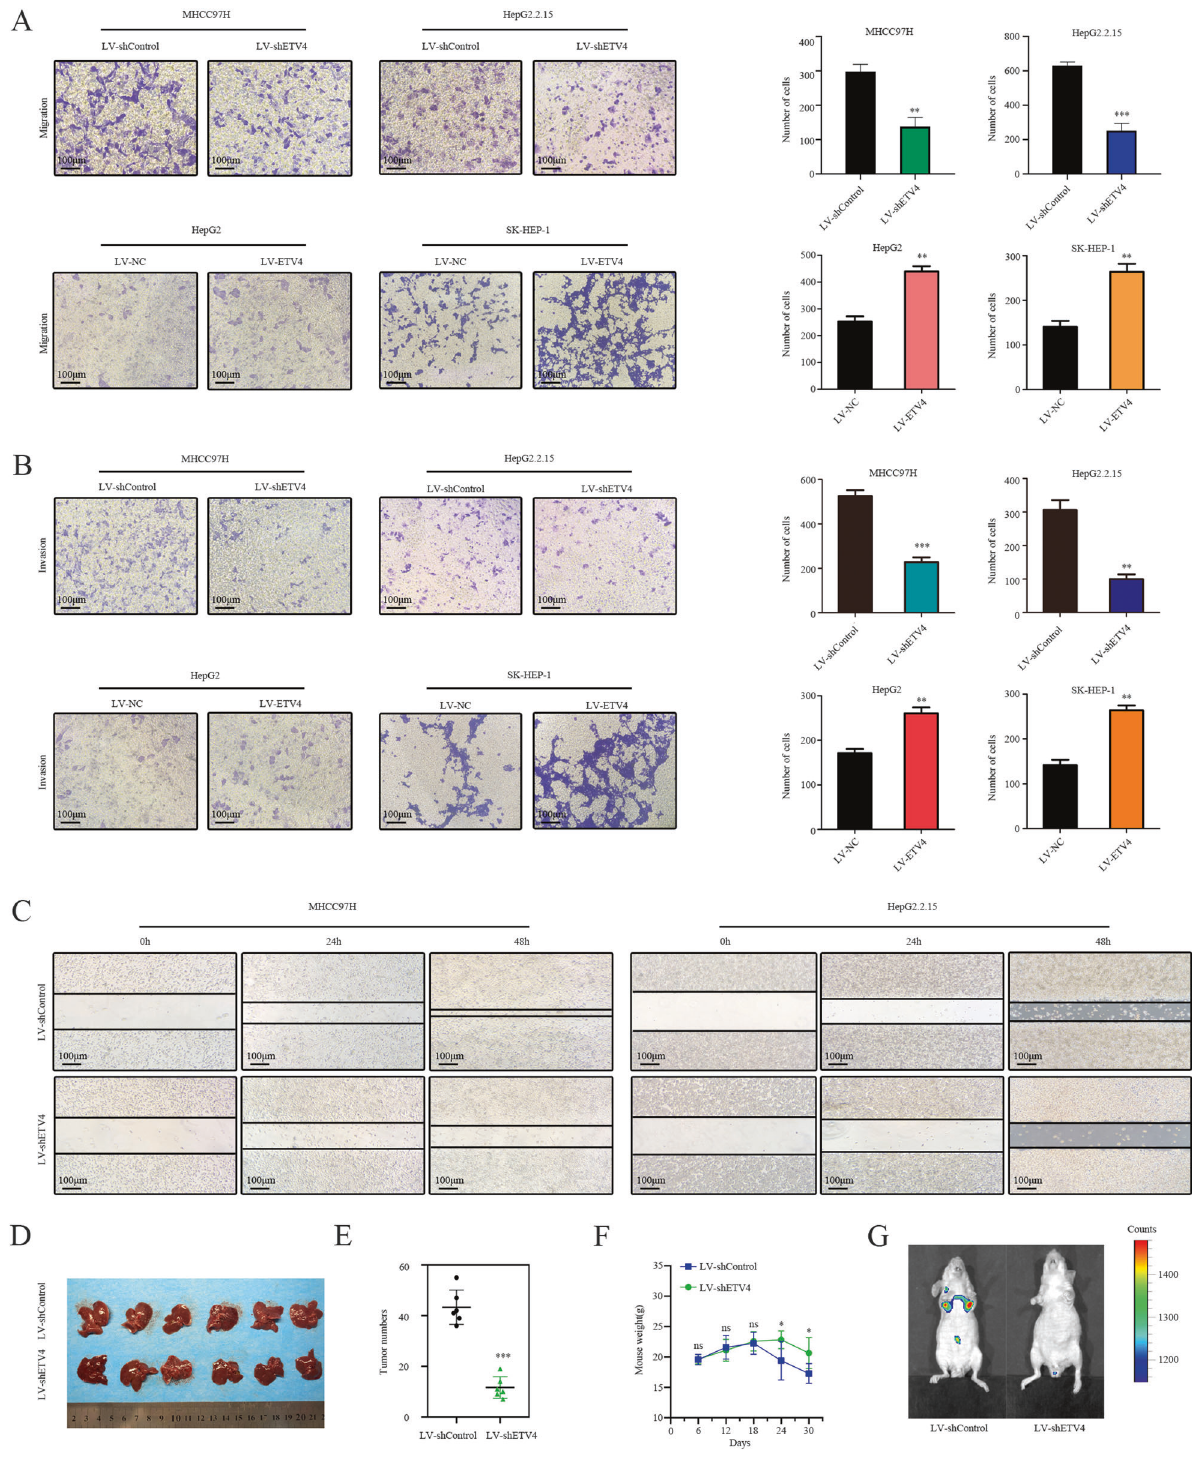
Fig. 3 ETV4 facilitates HCC cell migration and invasion in vitro and in vivo. A Transwell migration assays for MHCC97H and HepG2.2.15 or HepG2 and SK-HEP-1 cells with stable ETV4 knockdown or overexpression ( P < 0.01; P < 0.001; P < 0.01; P < 0.01). B Transwell invasion assays for MHCC97H and HepG2.2.15 or HepG2 and SK-HEP-1 cells with stable ETV4 knockdown or overexpression ( P < 0.001; P < 0.01; P < 0.01; P < 0.01). C Wound healing assay. Wound closure was delayed in stable ETV4 knockdown cells compared with control cells at 0, 24, and 48 h. D In vivo, tumor transfer was examined by injecting MHCC97H-LV-shControl (left) or MHCC97H-LV-shETV4 (right) cells into the tail veins of nude mice. The number of tumor lesions on the liver was counted after resection from the mice. E The statistical graph shows the number of tumor lesions on the liver in nude mice injected with stable ETV4 knockdown cells and control cells. F The body weight of mice in both groups was recorded every 6 days. G Representative lung metastasis images obtained by an IVIS in vivo imaging system after inoculation.